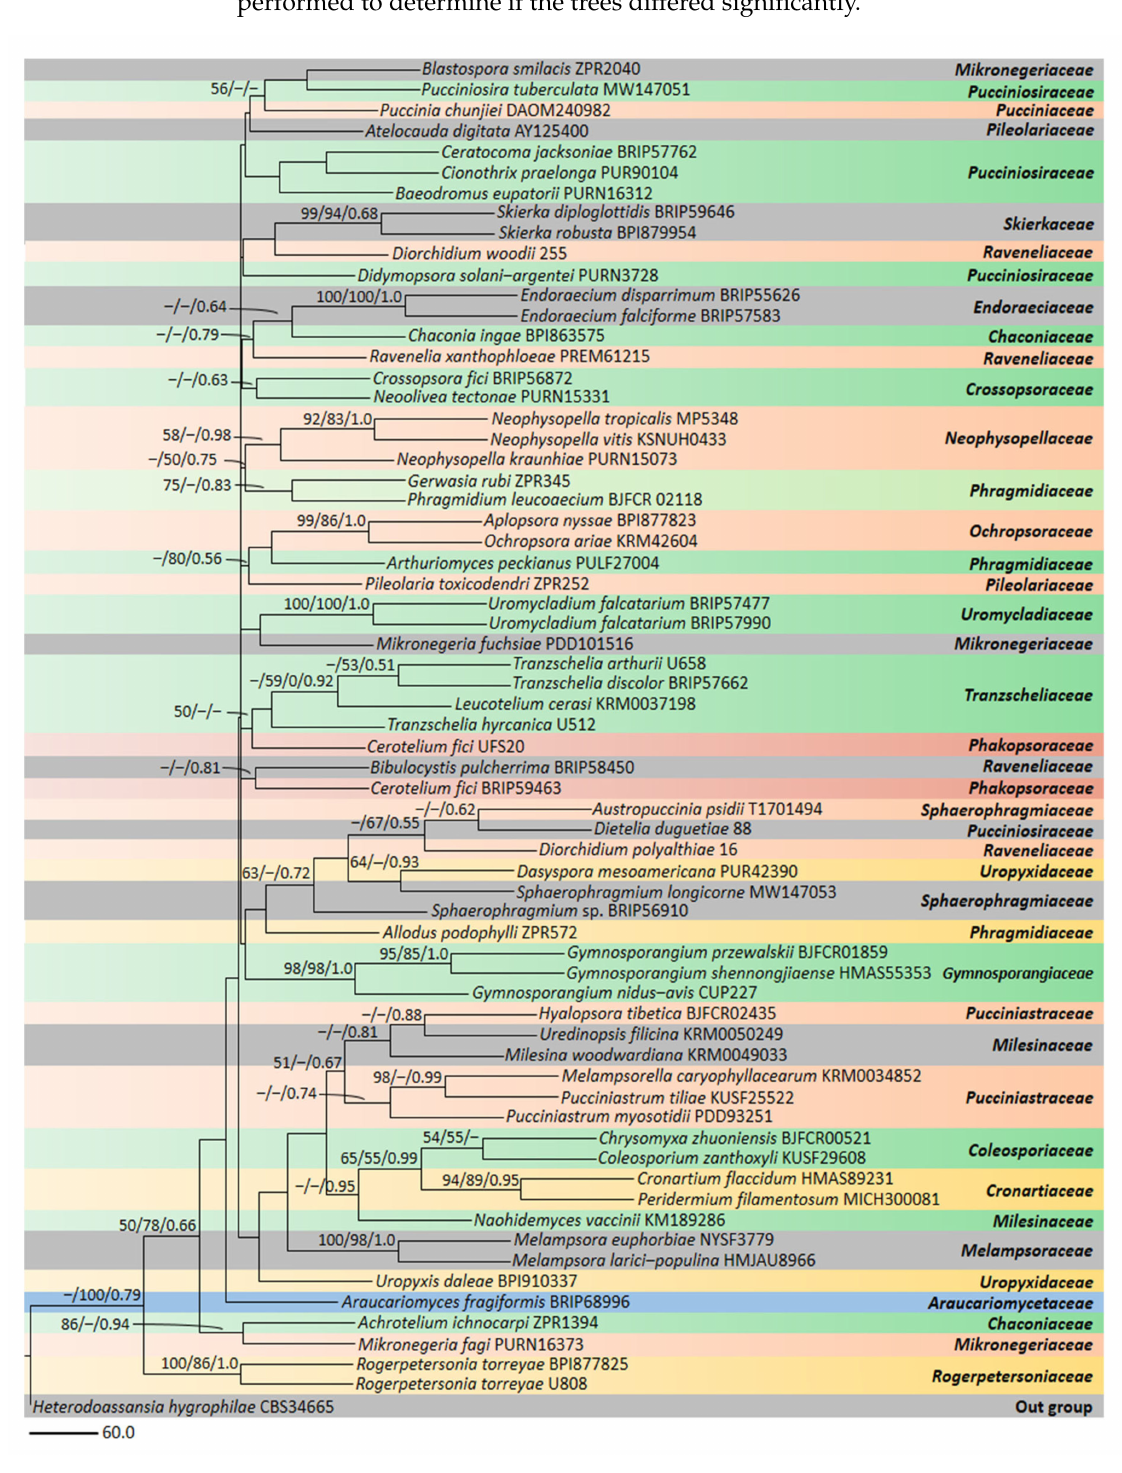
Figure 2. Phylogenetic placement of the rust genus Skierka , based on three genes ITS, LSU and SSU sequence data. The tree is rooted with Heterodoassansia hygrophilae (CBS34665) as the outgroup. The phylogenetic tree showed that the Skierka diploglottidis BRIP59646 and Skierka robusta BPI87995 ( Skierkaceae ) branch uniquely in the RAXML tree and branch with Diorchidium woodii 255 ( Raveneliaceae ) showing good bootstrap support at 99/94 in ML/MP/BI,